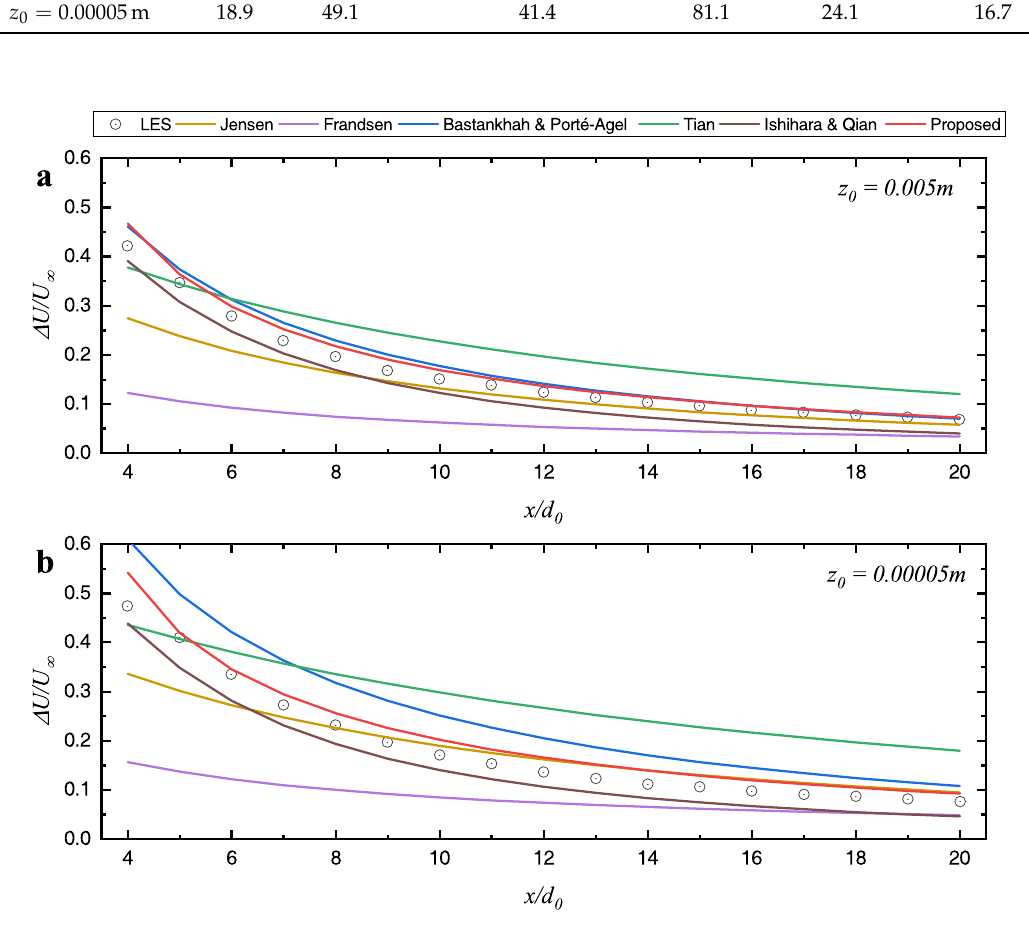
Figure 10. Comparison between the numerical simulation data and the predicted maximum normalized velocity deficit downwind of the wind turbine: ( a ) z 0 = 0.005m; ( b ) z 0 =